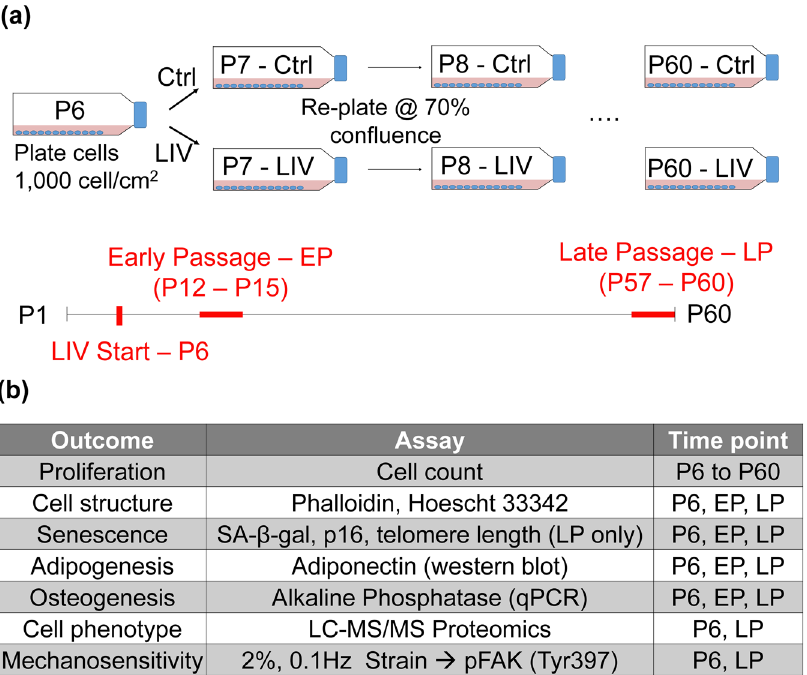
Figure 1. In vitro MSC expansion model and experimental design. ( a ) MSCs at passage 6 (P6) were serially passaged until P60. Experimental groups were subjected to twice-daily Low Intensity Vibration (LIV) regimen (0.7 g, 90 Hz, 20 minutes) outside of the incubator. While control MSCs were taken out of the incubator for 20 minutes twice daily, they were not vibrated. Each day, flasks were observed for confluence and when either one of the groups reached 70% confluence (non-contact), both groups were trypsinized, counted and re- plated at the density of 1000 cell/cm 2 . This protocol was repeated until passage 60 (P60). ( b ) Data collected between P12 and P15 were designated as early passage (EP) and data collected P57 and P60 were designated as late passage (LP). All assays were performed 24 h after plating with no LIV applied within the 24 h period. EP and LP samples were compared to P6 samples in separate, independent experiments with the exception of immunostaining where samples were fixed at different times but were stained and analyzed